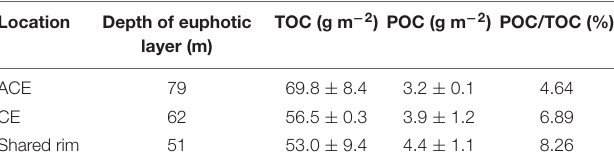
TABLE 1 | Inventory of organic carbon in euphotic zone in summer 2015 of northern slope of SCS. Location Depth of euphotic layer